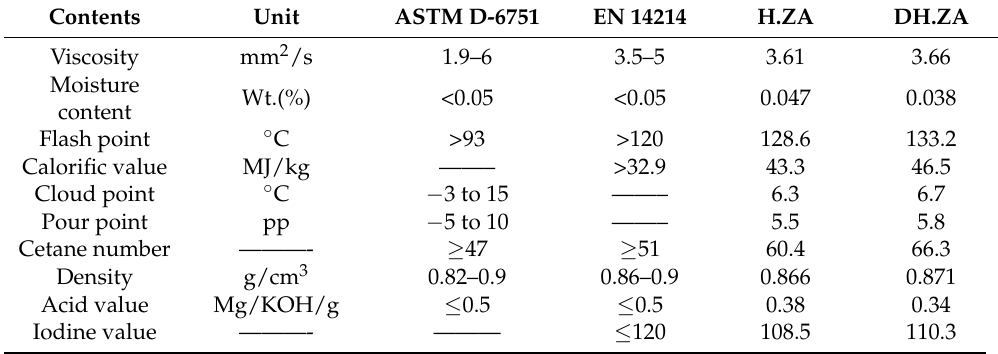
Table 2. The physical properties of the biodiesel samples obtained from H.ZA and DH.ZA